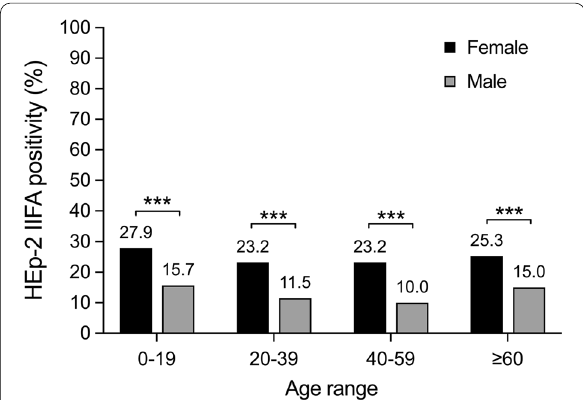
Fig. 1 HEp-2 IIFA positivity (%) according to sex and age range in 54,990 serum samples evaluated from January to June of 2017. The proportion of positive results was higher in the age groups of 0–19 years and 60 years, compared to the other age groups ≥ ( p < 0.001). The greater positivity of HEp-2 IIFA on female sex was observed in all age groups ( p < 0.001). Statistical differences by Mann– Whitney test ( p < 0.001) were represented by